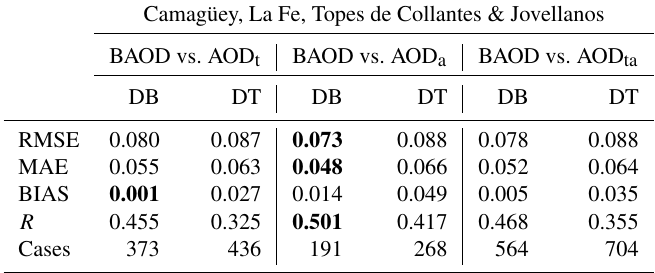
Table 8. Statistics from comparing the single observations of BAOD at the four actinometric stations coincident in space and time with the single observation (L2) of AOD t , AOD a and AOD ta . In bold are the values of best